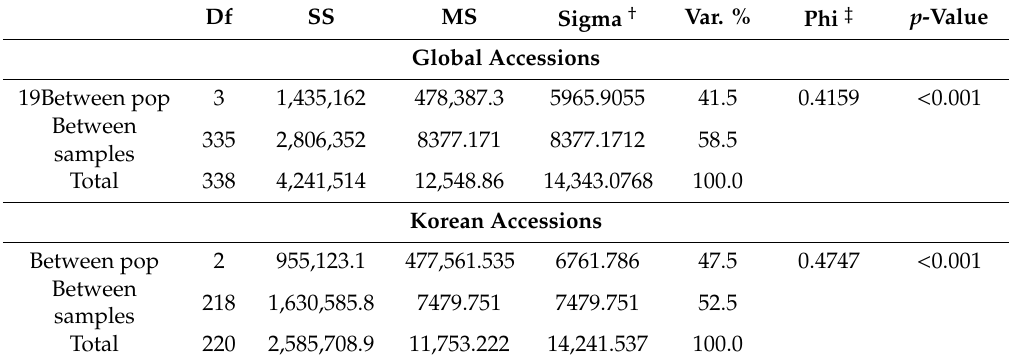
Table3. Analysisofmolecularvariance(AMOVA)amongandwithinpopulationsforcowpeaaccessions. Df SS MS Sigma